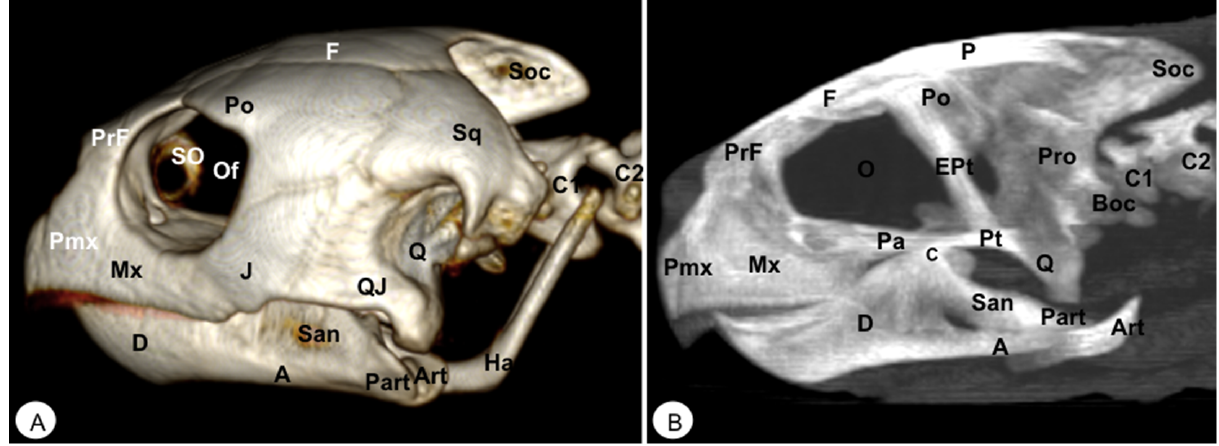
Figure 3. Head of Caretta caretta . ( A ) Lateral VR image. ( B ) Medial MIP image. Pmx: Premaxillary bone. Mx: Maxillary bone. PrF. Prefrontal bone. F: Frontal. Po: Postorbital. J: Jugal. SO: Scleral ossifications. QJ: Quadratojugal. Q: Quadrate. Sq: Squamosal. Boc: Basioccipital. Pt: Pterygoid. EPt: Epipterygoid. Pa: Palatine. P: Parietal. Soc: Supraoccipital. Pro: Prootic. C: Coronoid. O: Orbit. Of: Orbital fossa. D: Dentary. A: Angular. San: Surangular. Part: Prearticular. Art: Articular. Ha: Hyoid apparatus. C1: First cervical vertebra. C2: Second cervical vertebra.